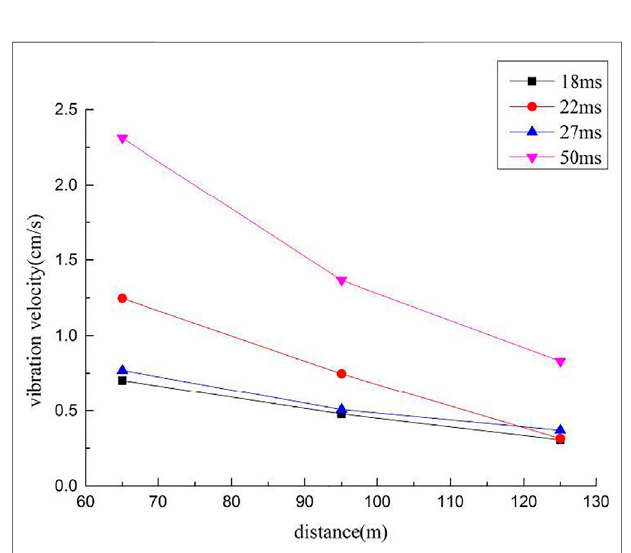
FIGURE8| Peakvibrationvelocityateachmeasuringpointwithdifferent delay times.